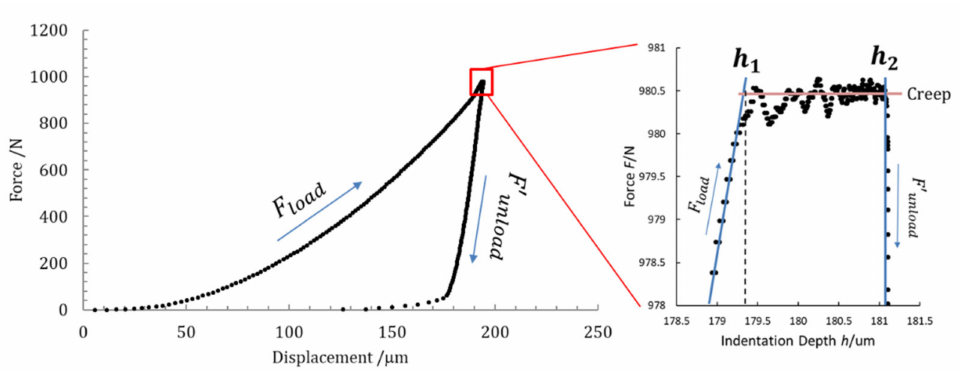
Figure 3. Loading–unloading paths of the indentation curve, expressed as a function of applied force and displacement with the indication of the creep of the material during the application of a constant